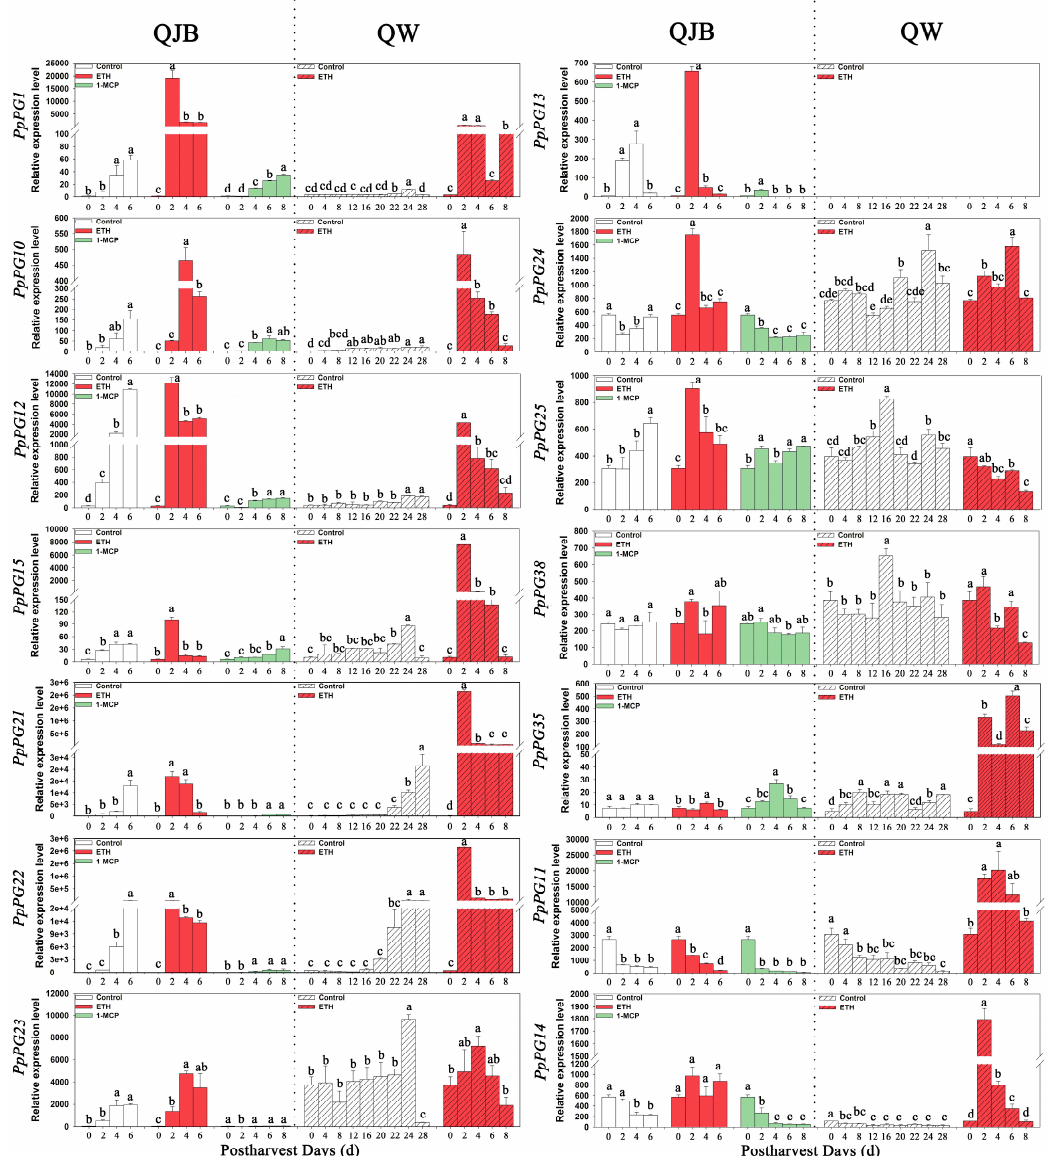
Figure 7. Expression levels of selected PpPG genes in control and ethylene-treated fruits during storage in two peach cultivars. 18S served as reference gene. Data are the means ± standard errors ( n = 3). Significant differences ( p < 0.05) between means are indicated by different letters.